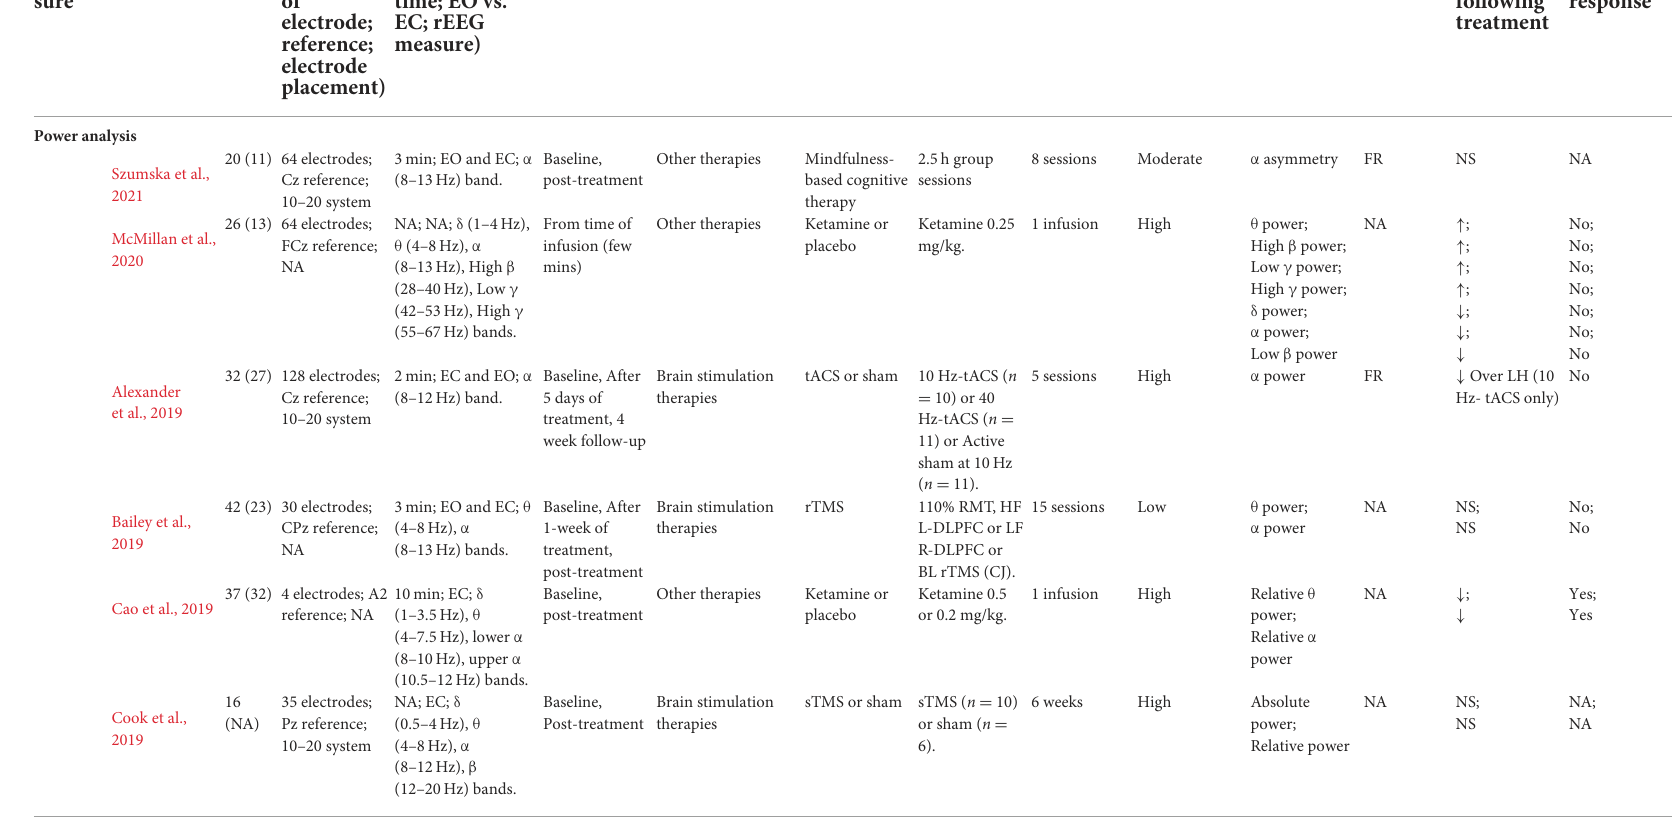
TABLE 1 Resting EEG outcomes for antidepressant, brain stimulation, and other